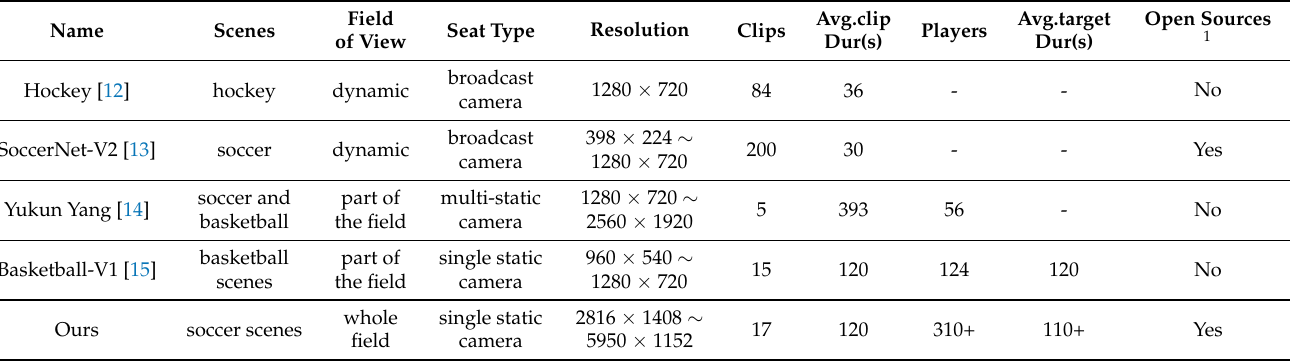
Table 1. Statistics of datasets in Sports